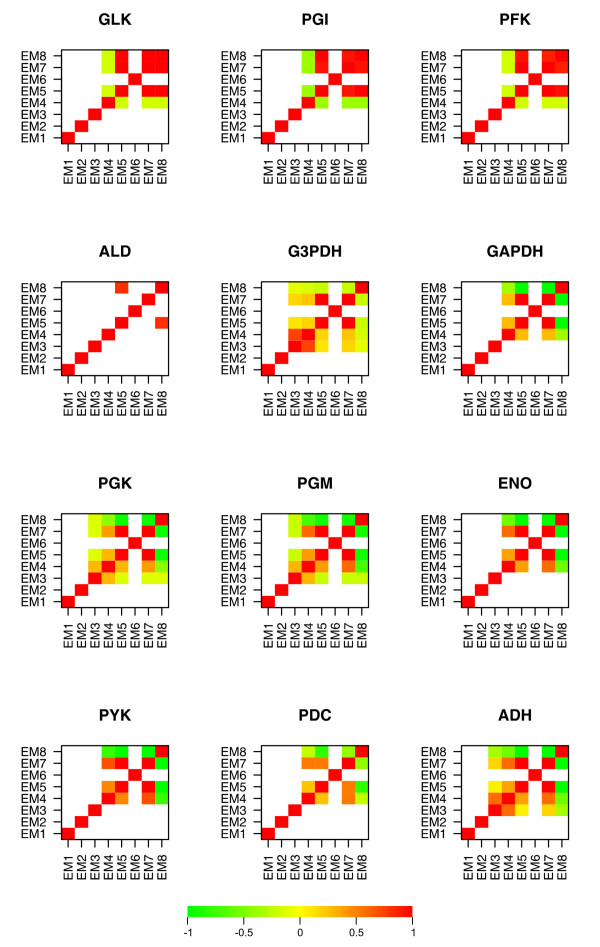
Correlations between elementary mode fluxes induced by individual enzymes. Correlations between variations of pairs of elementary mode fluxes under random variations of all kinetic parameters of each enzyme. Values are colour-coded according to the bar at the bottom of the figure. White squares indicate that no correlation coefficient could be calculated, i.e. that one of the two elementary modes retained a constant flux value.